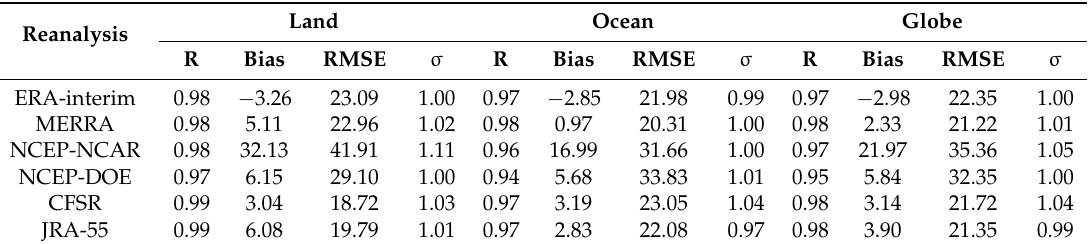
Table 7. Evaluation of monthly R s global reanalyses using CERES-EBAF data from 2001 to 2009 at 1 ˝ ˆ 1 ˝ grid scale over land, the oceans and the globe. Units are W/m 2 for bias and RMSE. Land Reanalysis